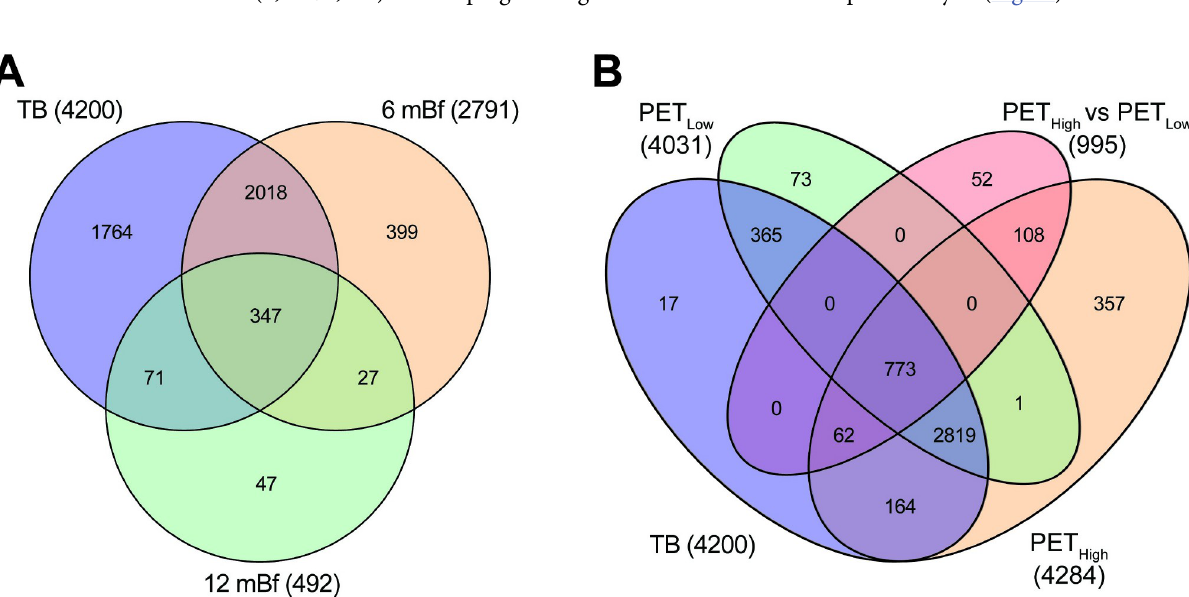
(3,957/4,200) of the upregulated genes identified in the complete analysis (Fig 1B). Of the 995